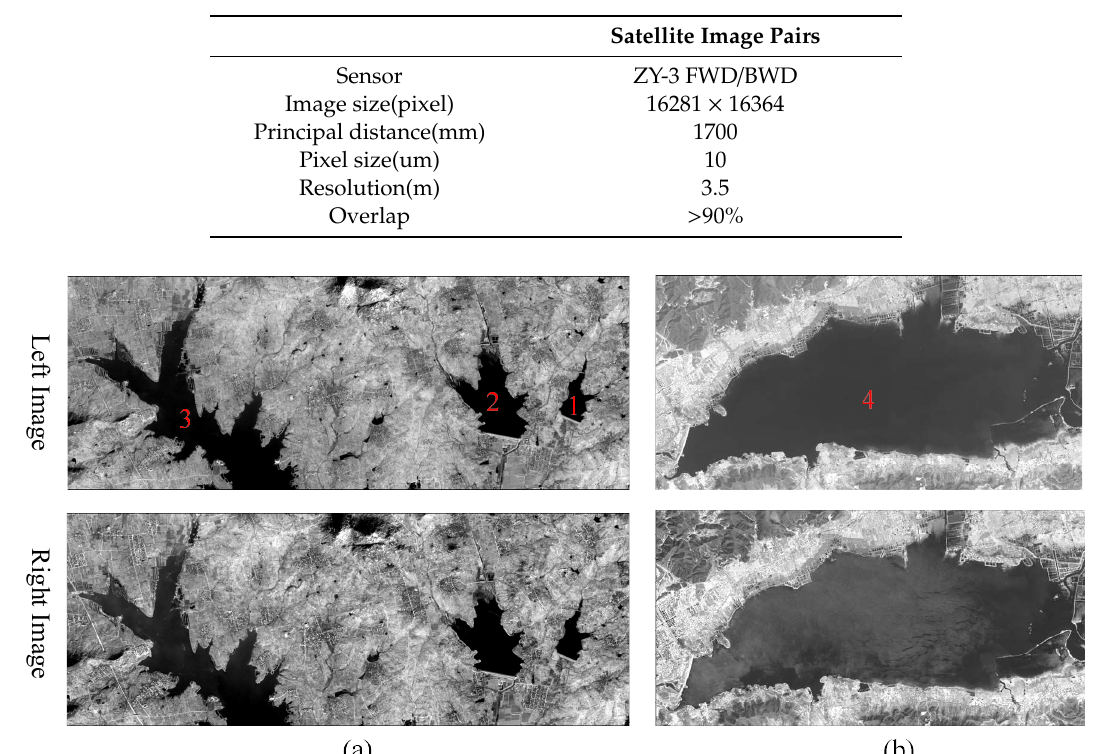
Table 1. Information of ZY-3 image pairs.